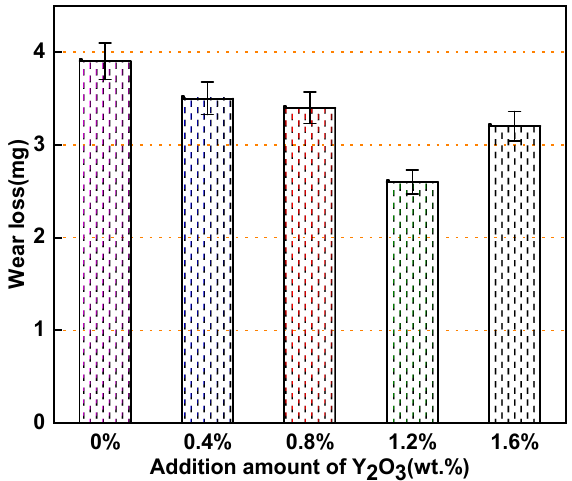
Figure 13. Wear loss of Y2O3 modified surfacing layer with different content.